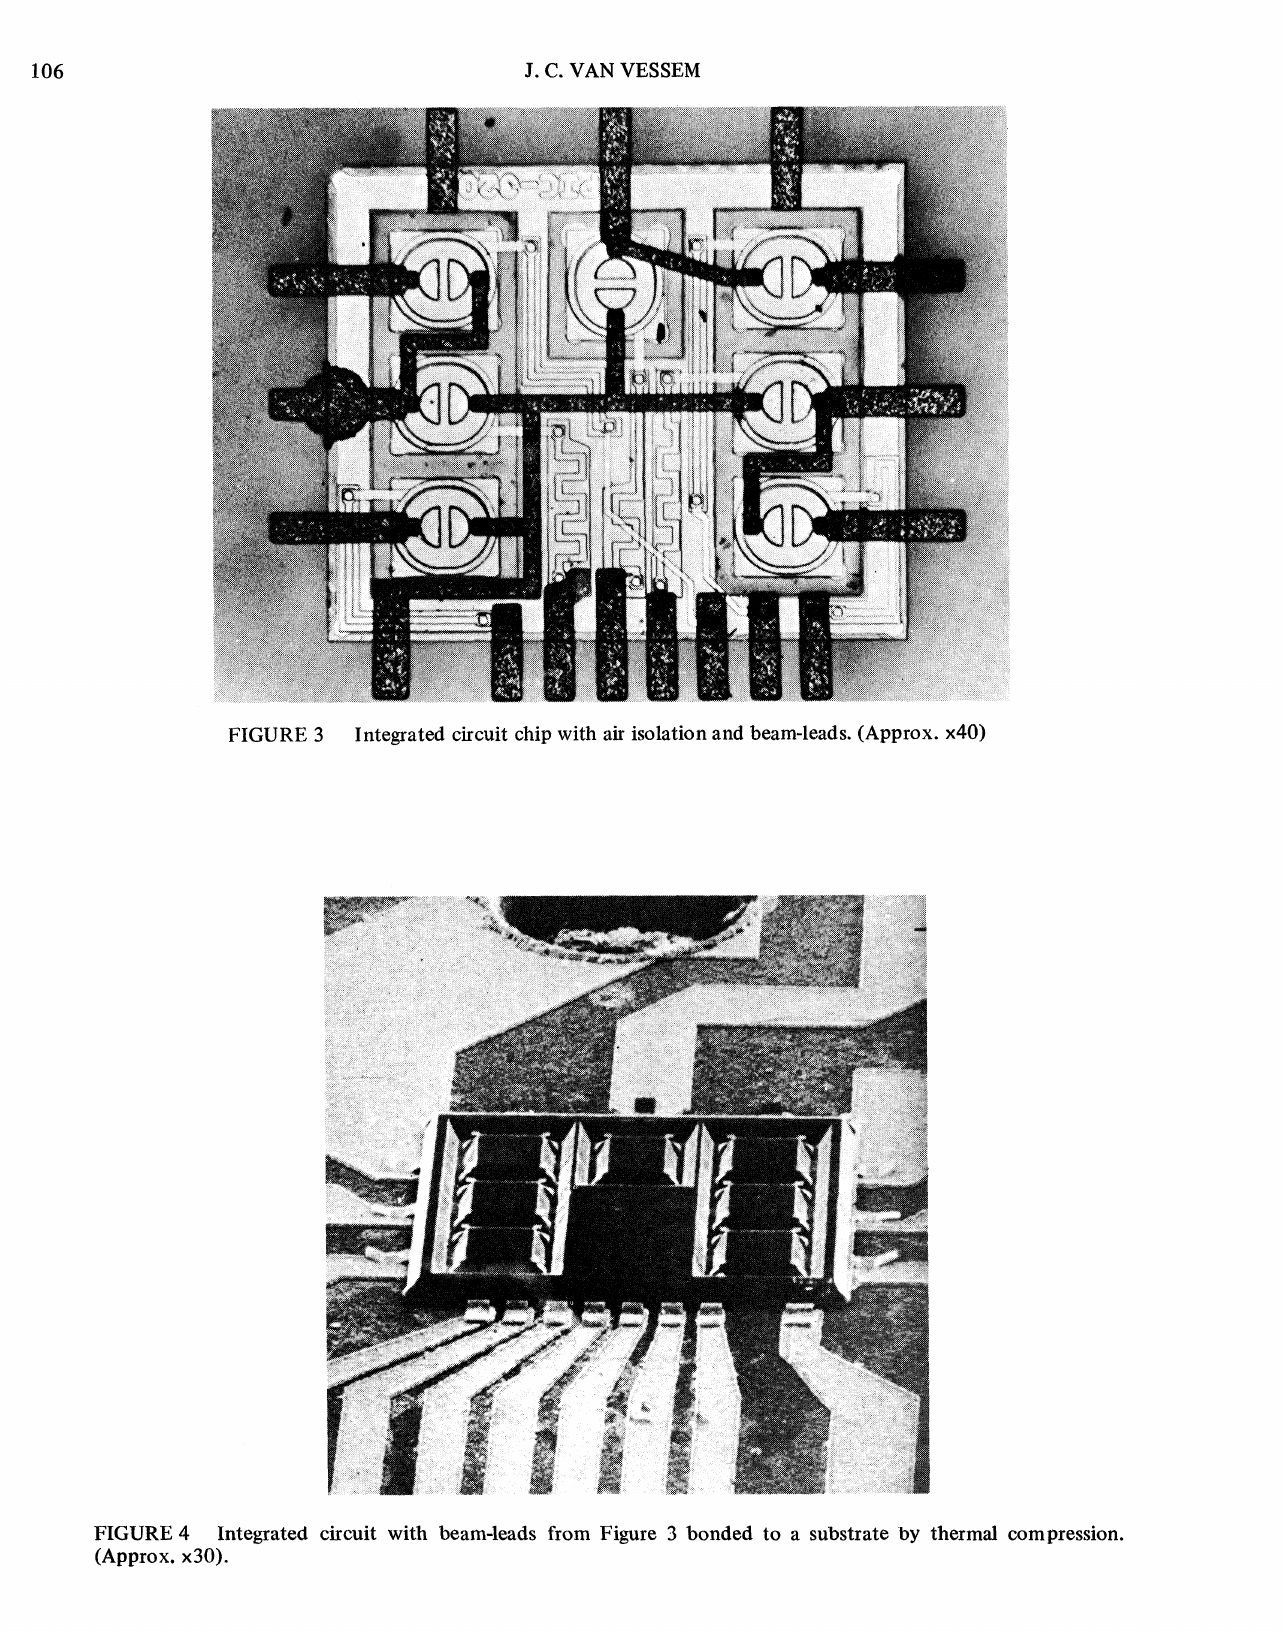
FIGURE 4 Integrated circuit with beam-leads from Figure 3 bonded to a substrate by thermal compression. (Approx.